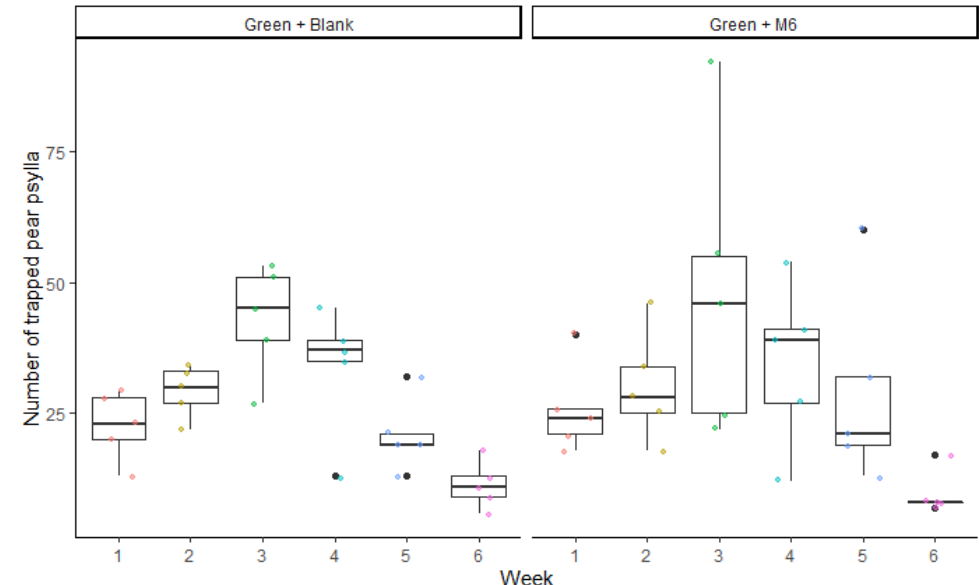
Figure 5. Average numbers of Cacopsylla pyri captured by five sticky traps in field experiment per week. The two trap types (green traps with blank nanofibers or green traps with M6-loaded nanofibers) were deployed in five blocks of pear trees (randomized block design) between 21 June 2021 and 2 August 2021. Boxes correspond to the 25th and 75th percentiles, medians appear as lines, and whiskers extend to 1.5 times of the interquartile ranges. Dots represent raw values.